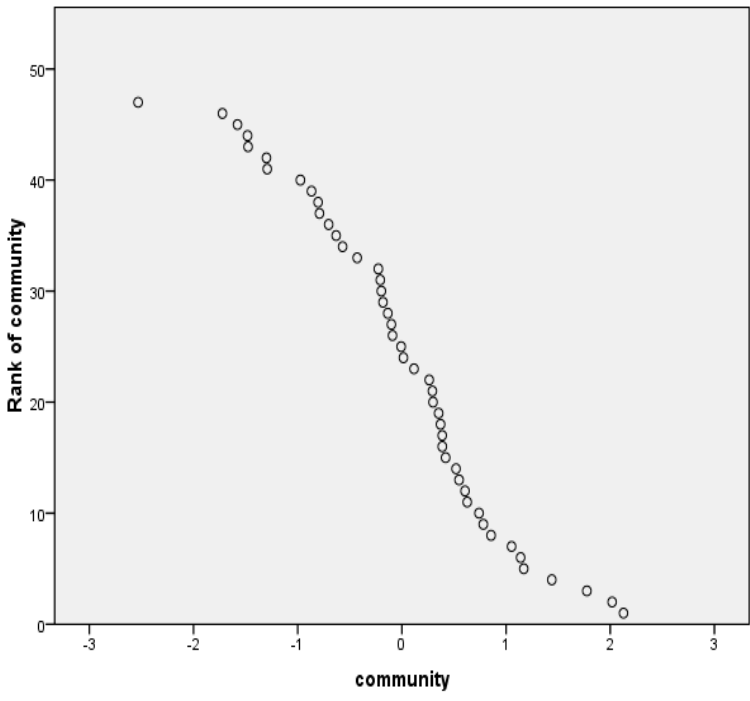
Figure 3. Scatterplot of PC “community formation” against its ranks.